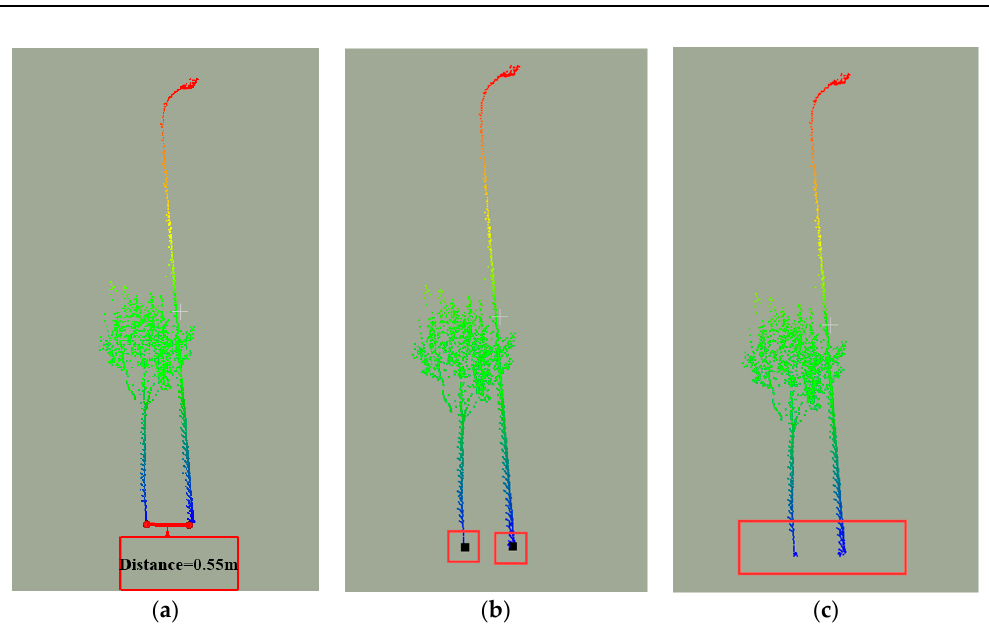
Figure 8. Parameter setting example. ( a ) Original cluster with two street object whose horizontal distance between them is 0.55 m. ( b ) Pole candidate position detection result with two positions detected when Ir is configured as 0.45 m. ( c ) Pole candidate position detect result with no position detected when Ir is configured as 0.6m.